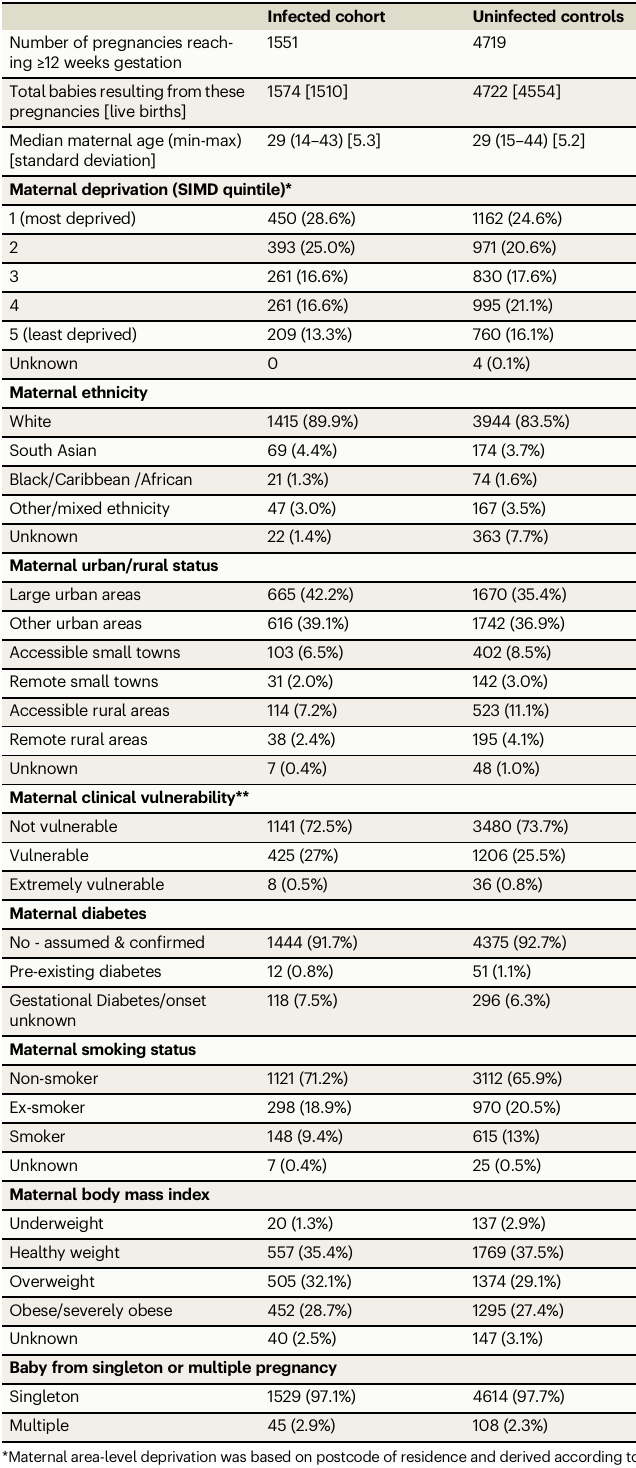
Table4| Keysociodemographic and clinicalcharacteristicsof infected and control